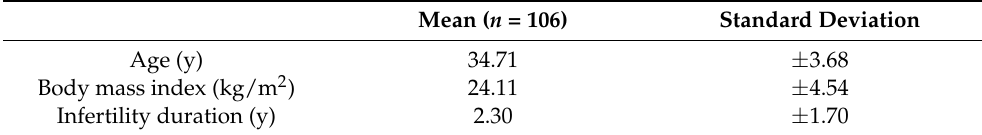
Table 1. Patient characteristics.